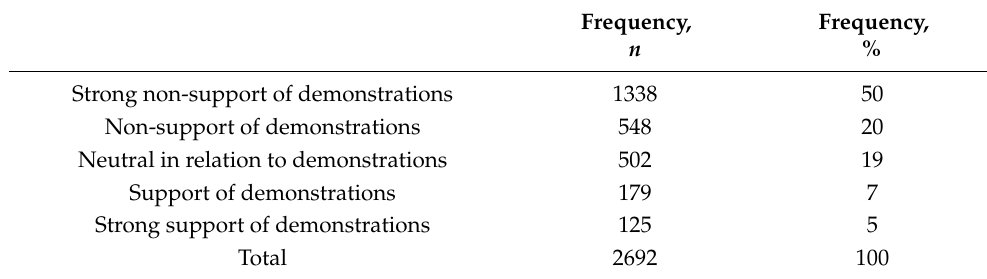
Table 2. Support of the demonstrations against the COVID-19 lockdown measures.